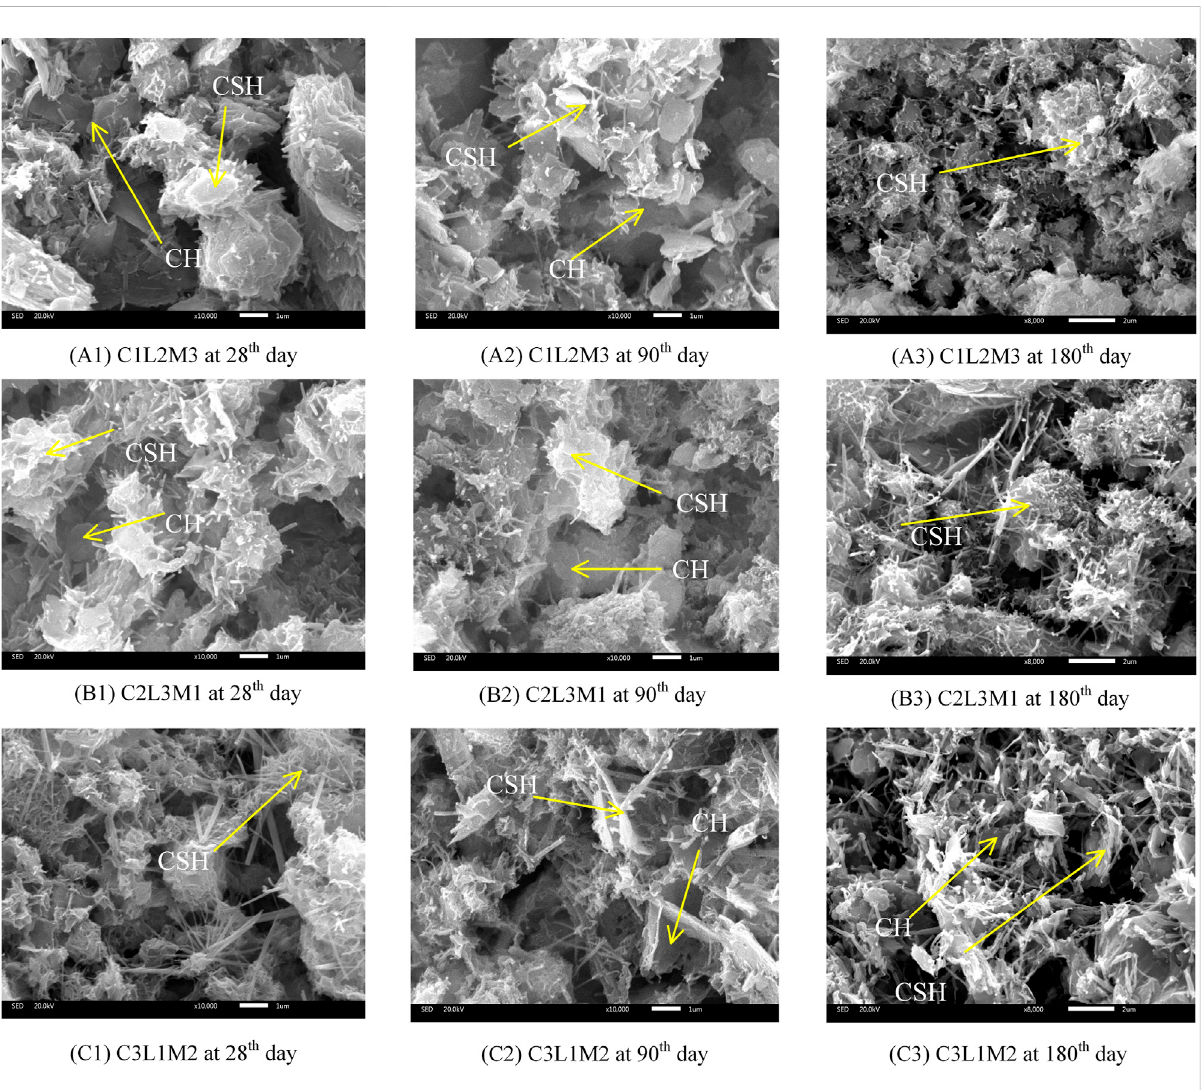
FIGURE 9 Microstructures of S/S sediments after different curing periods: (A1) C1L2M3 at the 28th day, (A2) C1L2M3 at the 90th day, (A3) C1L2M3 at the 180thday, (B1) C2L3M1 atthe28th day, (B2) C2L3M1 atthe90th day, (B3) C2L3M1 atthe180th day, (C1) C3L1M2 atthe28thday, (C2) C3L1M2 atthe 90th day, and (C3) C3L1M2 at the 180th